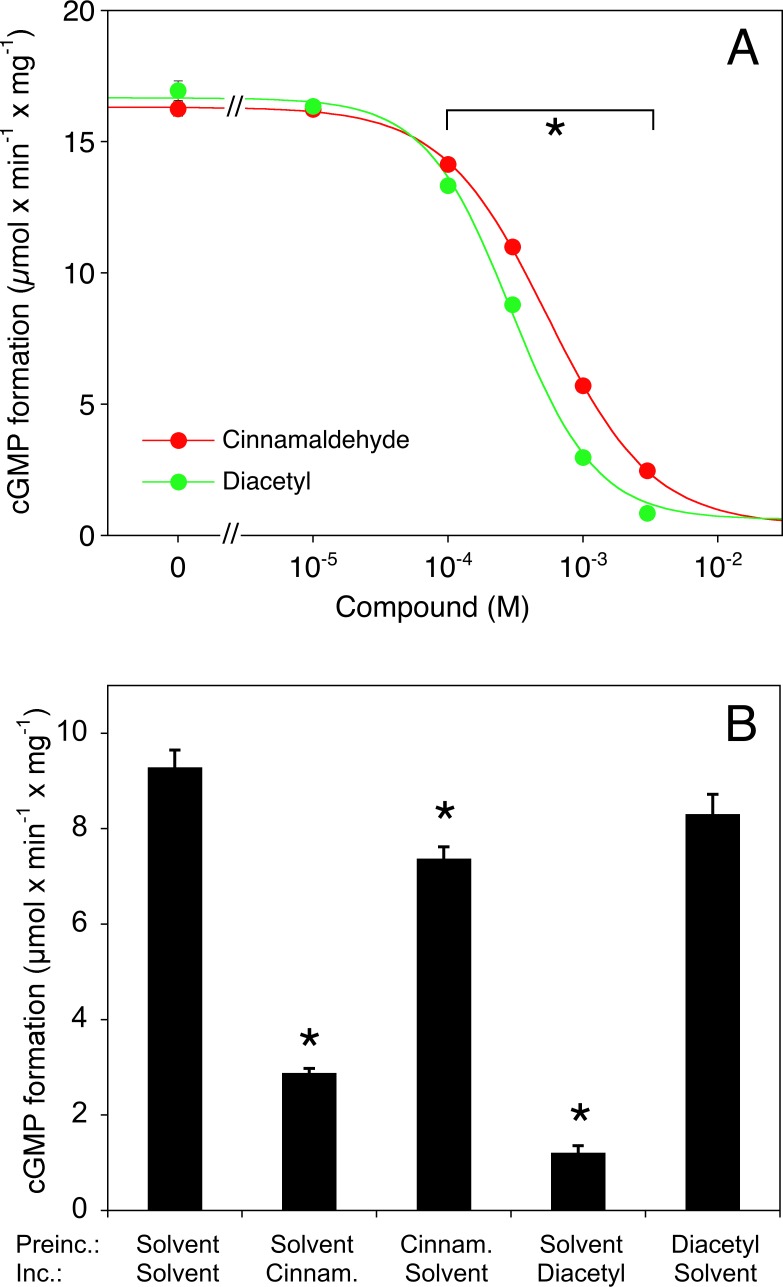
Effects of cinnamaldehyde and diacetyl concentration on sGC activity (A) and reversibility of inhibition (B). A, Purified bovine lung sGC (50 ng) was stimulated with DEA/NO (0.05 μM) in the presence of DMSO (0.1% as solvent control) or increasing concentrations of cinnamaldehyde and diacetyl (0.01–3 mM each). B, The enzyme (50 ng) was pre-incubated with DMSO (0.1% as solvent control) or flavorings (1 mM each) for 5 minutes and subsequently diluted 50-fold in reaction mixture, followed by determination for enzyme activity by incubation for 10 minutes in the presence of 0.05 μM DEA/NO in the absence or presence of the flavorings (1 mM each). Data are expressed as mean values±SEM (n = 3). Note that the error bars in panel A are smaller than the symbols. *p<0.05 vs. controls in the absence of cinnamaldehyde (ANOVA with Dunnett's post hoc test).